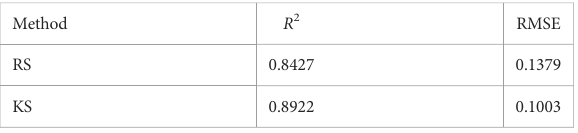
TABLE 1 The results of sample division by the RS and KS